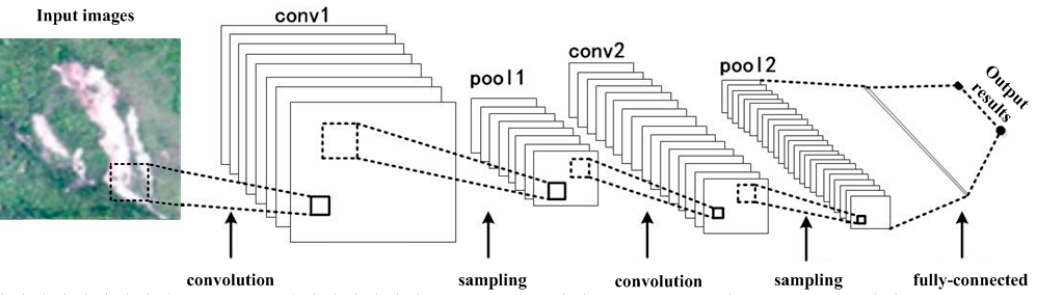
Figure 5. Construction of deep convolution neural network.